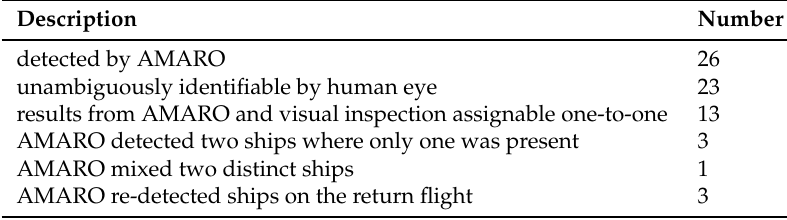
Table 9. Comparison of the results from AMARO with visual inspection.